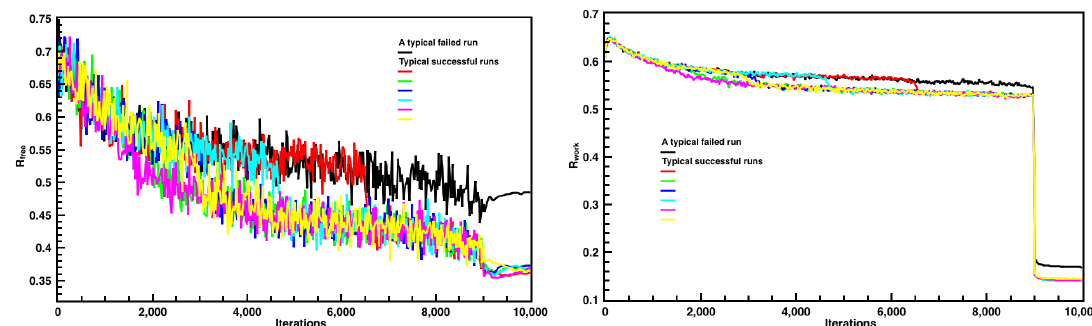
Figure 1. The evolution of R free and R work .